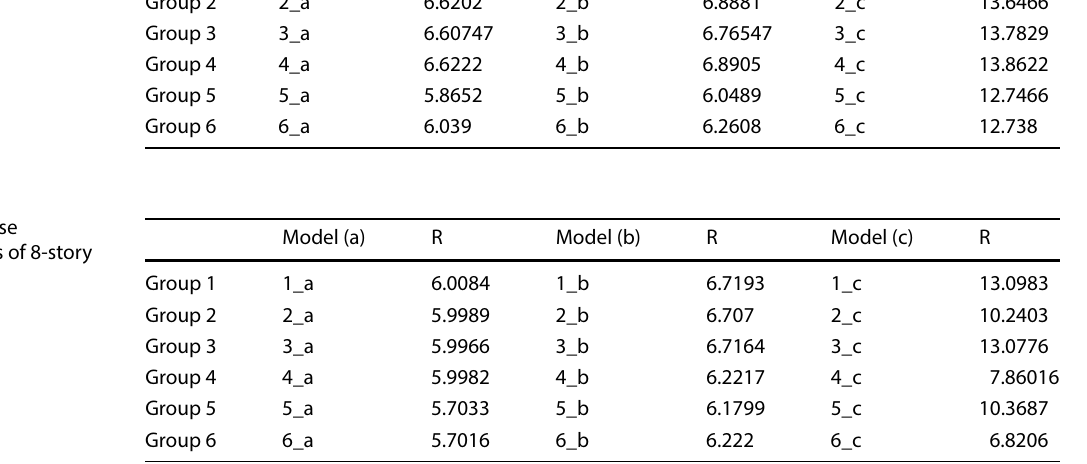
Table 6 The response modification factors of 8-story 2-span structure